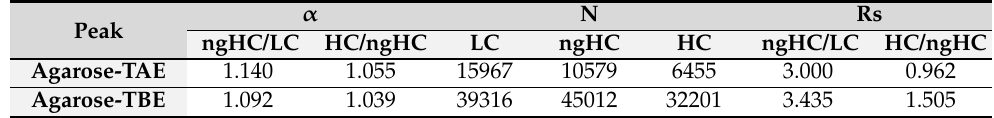
Figure 1. Capillary SDS agarose gel electrophoresis separation of the omalizumab subunits in Tris– acetate–EDTA (TAE, upper trace) and Tris–borate–EDTA (TBE, lower trace) background electro ‐ Table 1. Comparison of the separation characteristics ( α –selectivity, N -theoretical plate number, lytes. Peaks: 1–10 kDa internal standard; 2–LC; 3–ngHC; 4–HC. Conditions: bare fused silica capil ‐ Rs–resolution) with agarose–TAE and agarose-TBE gel-buffer systems. lary (20 cm effective length, 30 cm total length, 50 μ m i.d.); UV detection at 214 nm; E = 500 V/cm in reversed polarity (cathode at the injection side); Separation temperature: 25 °C; Electrokinetic injec ‐ tion: 5 kV for 10 s.